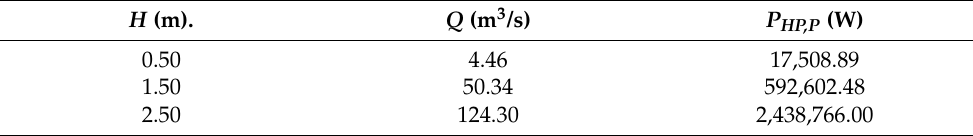
Table 4. Insight into the potential power of the turbines with respect of the potential hydro energy for the Gornja Dobra